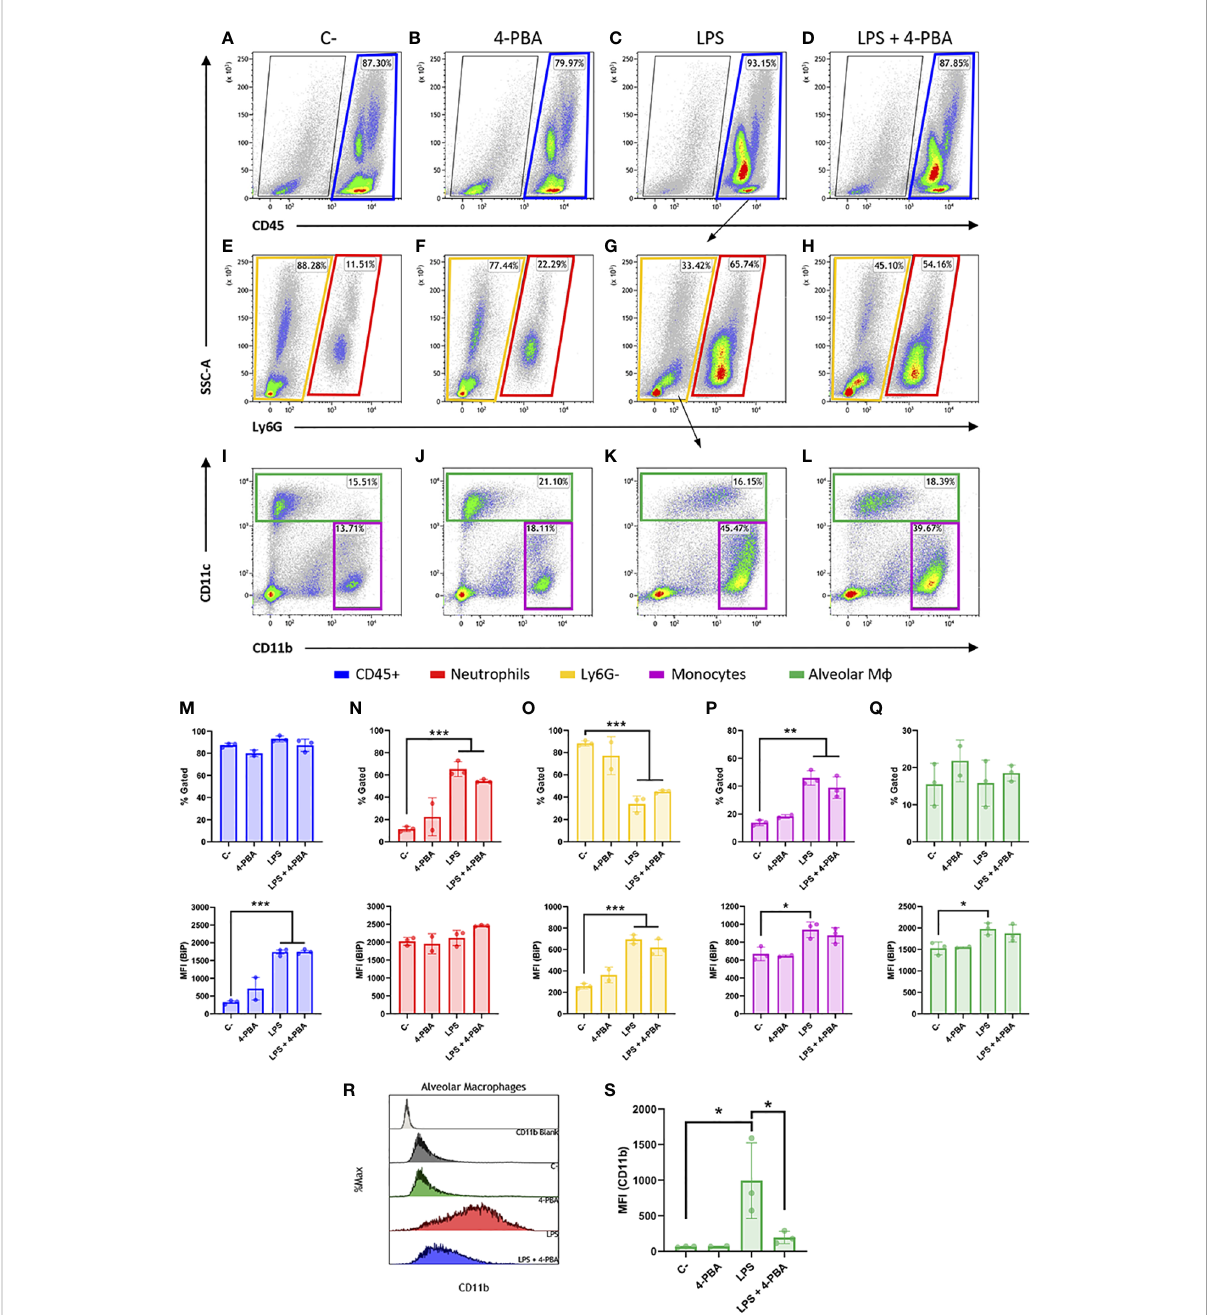
FIGURE 4 Cell surface BiP levels in immune lineages during the hyperin fl ammatory response. (A – D) Representative fl ow cytometry plots for CD45 + cells in blue squares. (E – H) Neutrophils are de fi ned as CD45 + Ly6G + in red squares. (I – L) Among the CD45 + Ly6G - population in yellow squares, we de fi ned alveolar macrophages and DCs (CD45 + Ly6G - CD11c + ) in green squares and monocytes as well as other myeloid phenotypes (CD45 + Ly6G - CD11b + CD11c -/low ) in purple squares (n=3 mice per group, n=2 for “ 4-PBA ” group). (M – Q) Percentage of gated cells and cell surface BiP levels measured by Median Fluorescence Intensity (MFI) of tagged csBiP antibody are represented in bar plots for every de fi ned population. (R, S) Histogram graph show the intensity distribution of CD11b marker among Alveolar M j population (R) also represented as the average of its correspondent MFI in a bar plot (S) . All bar plots show mean ± SD for every treatment into the de fi ned population. * P < 0.05, ** P < 0.01, *** P < 0.001 indicate statistically signi fi cant differences versus C- samples for a One-Way ANOVA with a Tukey ’ s multiple comparisons